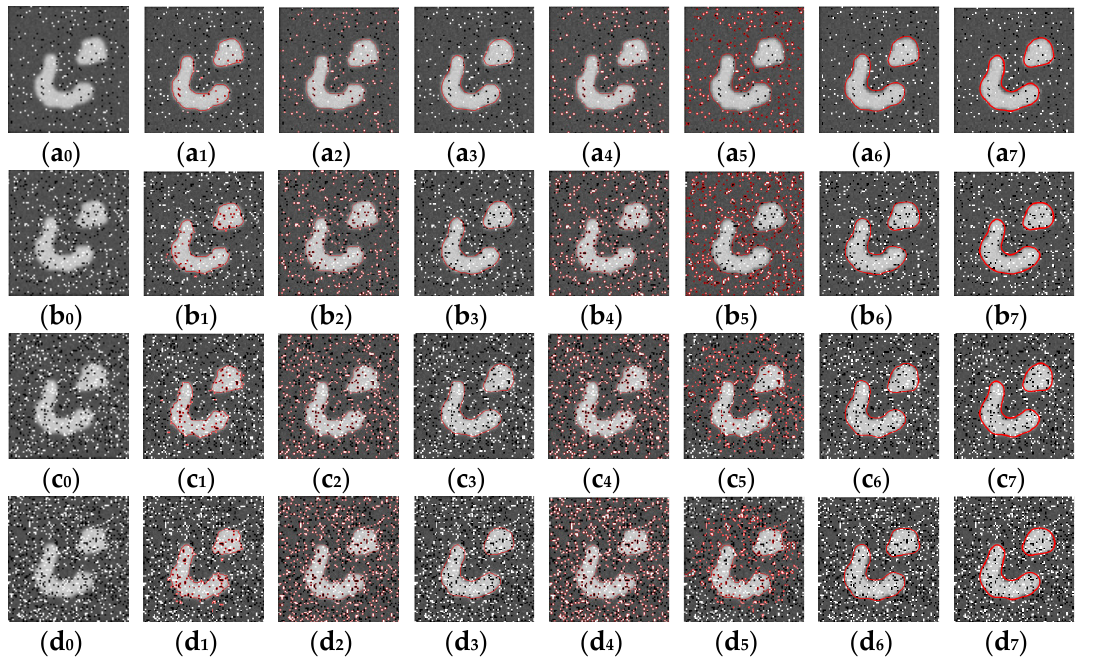
and 0.8. Columns 2 to 7 show the segmentation results of the LBF model, CV model, model from [16], LIF model, LSACM model, and model from [27], respectively, and column 8 shows the segmentation results of the NFD-LIF model.